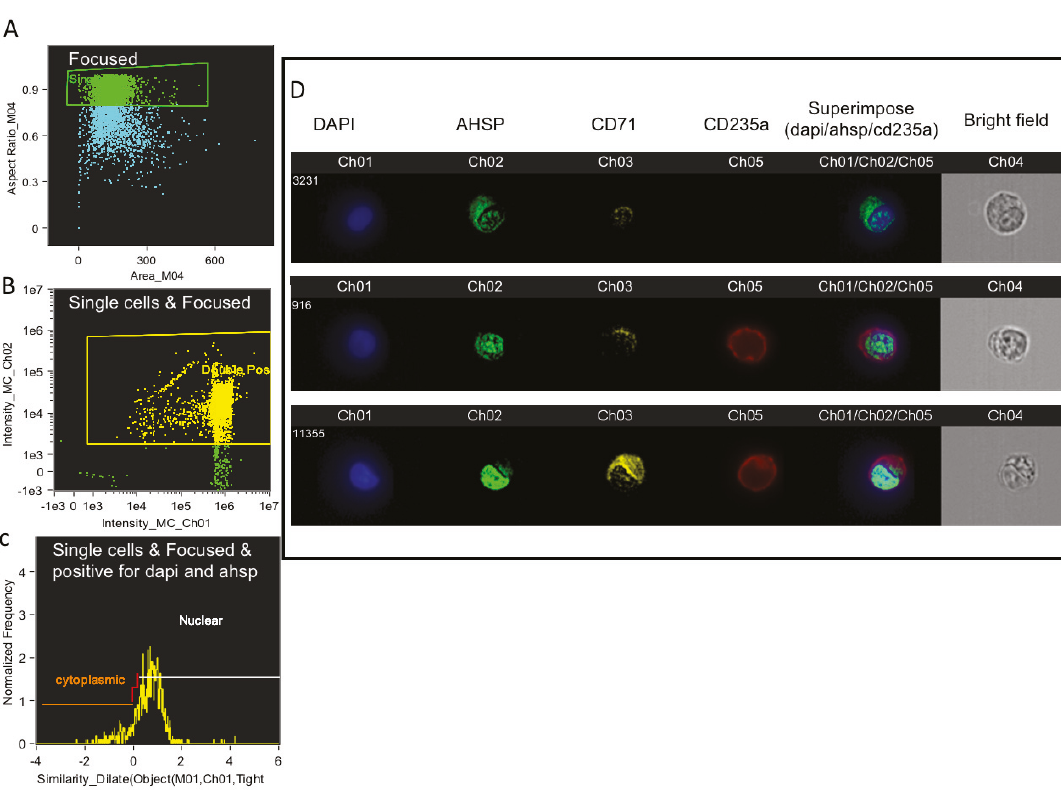
Figure 5. Representative images from AMNIS image flow of bone marrow derived erythroblasts on culture day 10 using multispectral imaging flow cytometry (MIFC) and analyzed by the IDEAS software. ( A ) Single cells were found on the camera’s focus. Then MIFC identified the nuclear and total cell areas using DAPI and brightfields respectively. ( B ) Dual expressing cells were gated on DAPI and FITC channel respectively. ( C ) Cytoplasmic area and nuclear area were defined on DAPI against frequency on histograms. The di ff erence between the two were used to identify the nuclear and total cell areas using the DAPI and brightfield channels. ( D ) Representative images were selected to show the DAPI signal defining the nucleus and the remaining area within the overlaid brightfield image defining the cytoplasm to analyze RNA and protein expression and